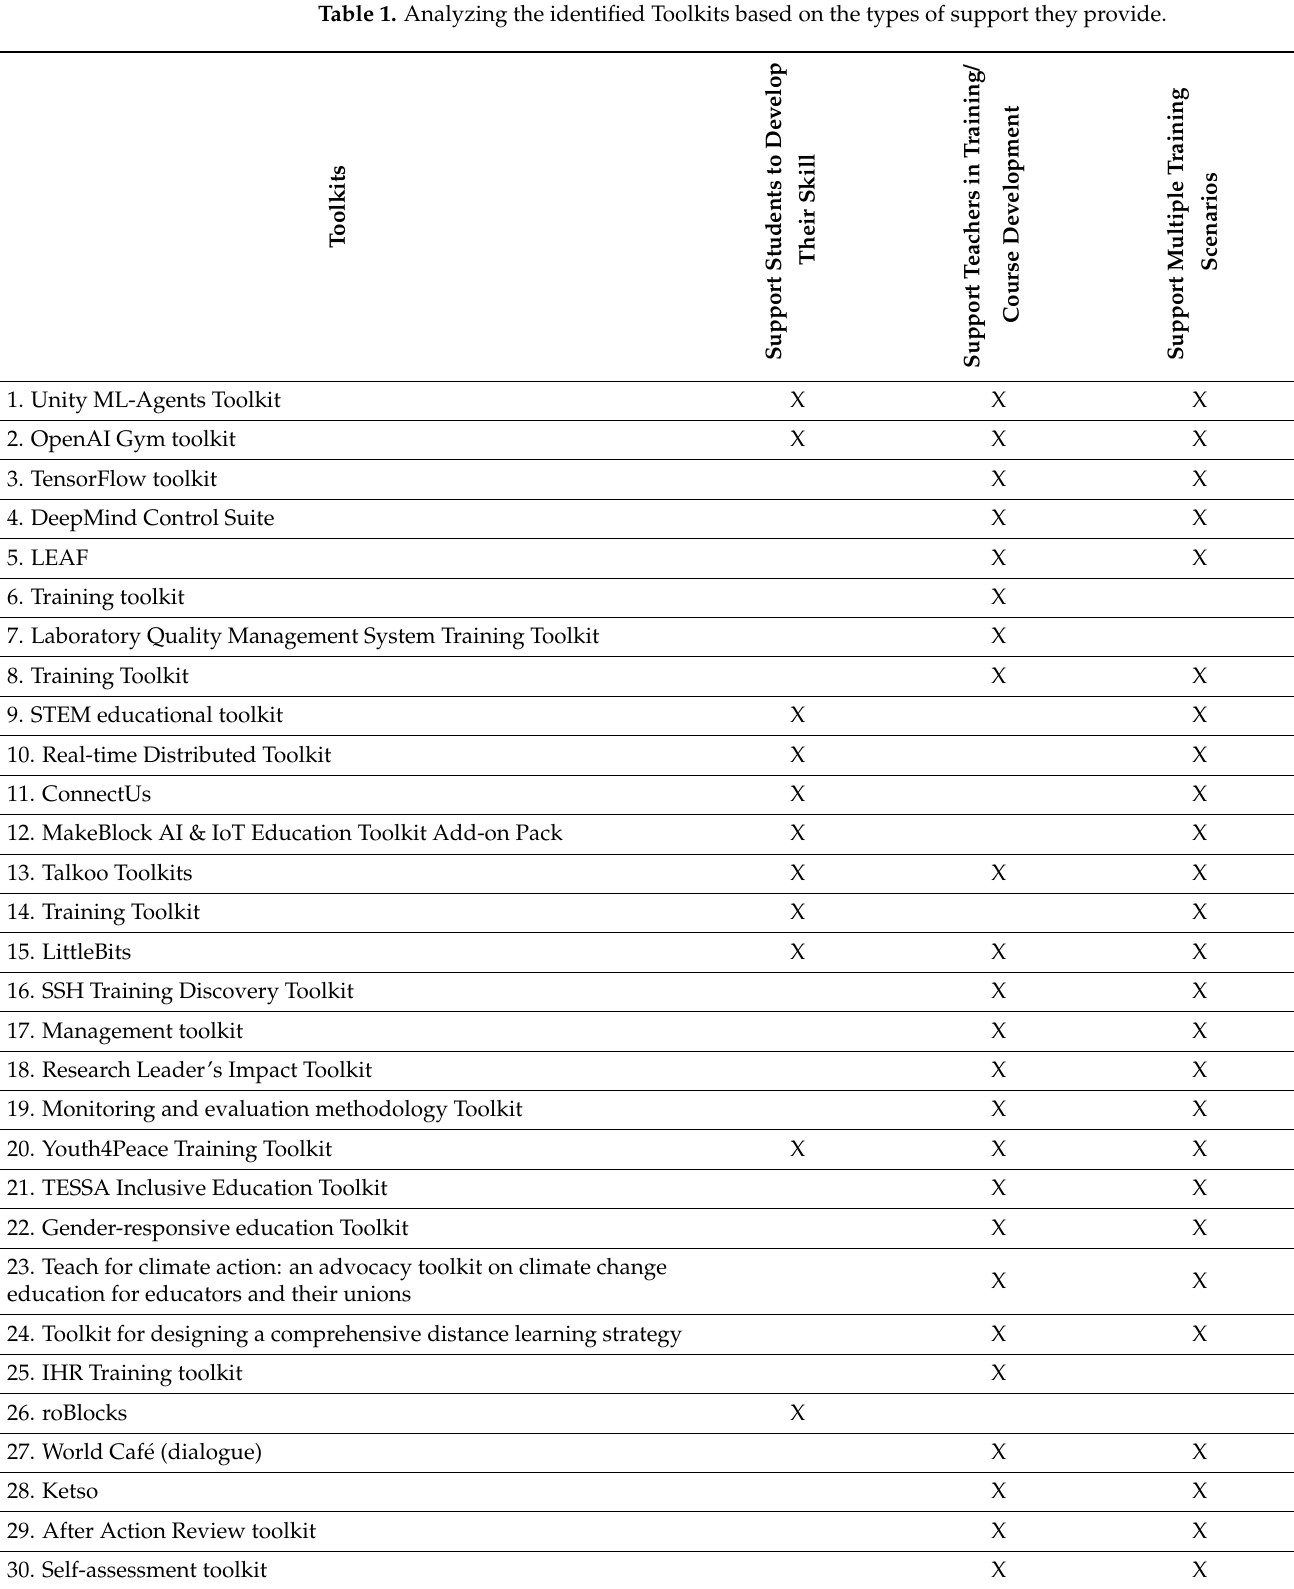
Table 1. Analyzing the identified Toolkits based on the types of support they